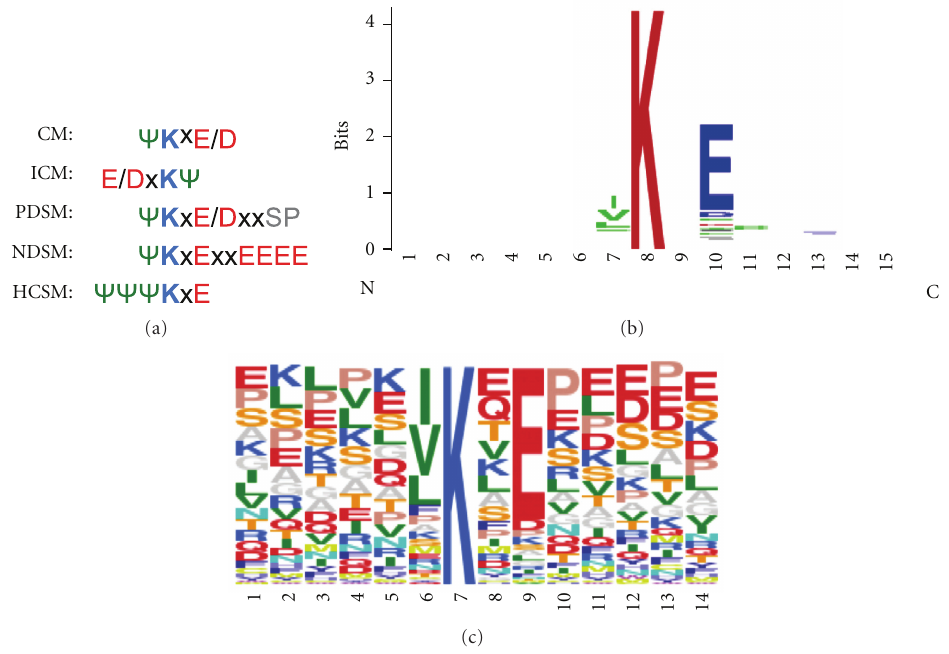
Figure 3: Sequence alignment SUMO consensus motifs. (a) Amino acid sequence alignment of the canonical SUMO consensus motif ( Ψ represents a hydrophobic amino acid, K is the Lys modified by SUMO and x represents any amino acid). CM: canonical consensus motif. ICM: inverted consensus motif. PDSM: phosphorylation-dependent SUMO motif, NDSM: negatively charged amino-acid-dependent SUMO motif, HCSM: hydrophobic cluster SUMO motif. Amino acids in blue: basic, red: acid, green: hydrophobic, gray: phospho serine. (b) WebLogo [64] representation of the consensus motif of SUMOylated proteins reported in the phosphosite database on Fri Feb 03 08:31:18 EST 2012 (PhosphoSitePlus [65], http://www.phosphosite.org/). (c) The same SUMO motif aligned using Sequence Logo. Amino acid sequences are represented by frequency on the identified